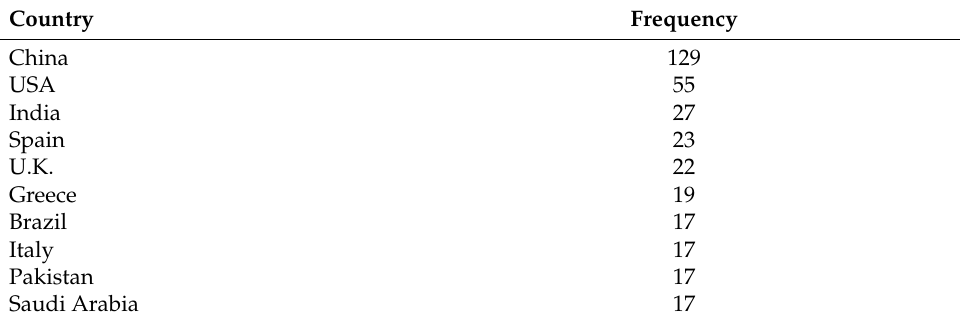
Table 8. Country scientific production.